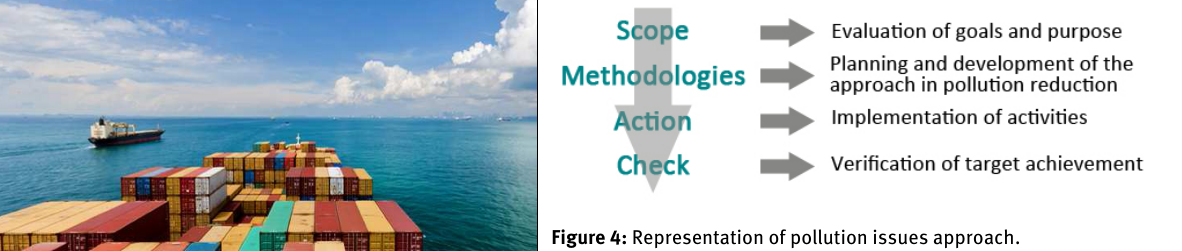
Figure 4: Representation of pollution issues